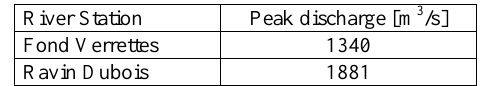
Table 1. Peak discharge values estimated for the 2004